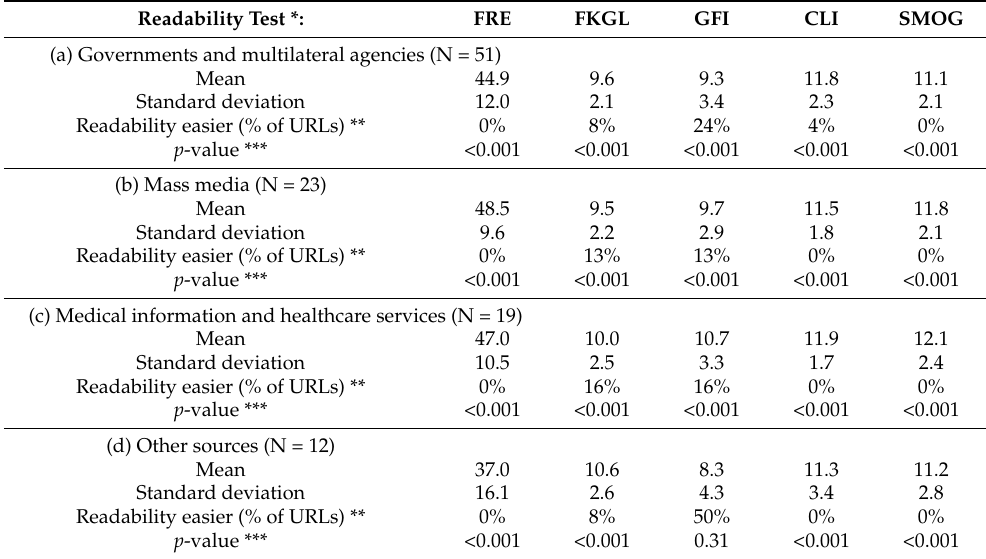
Table 3. Readability test scores by source